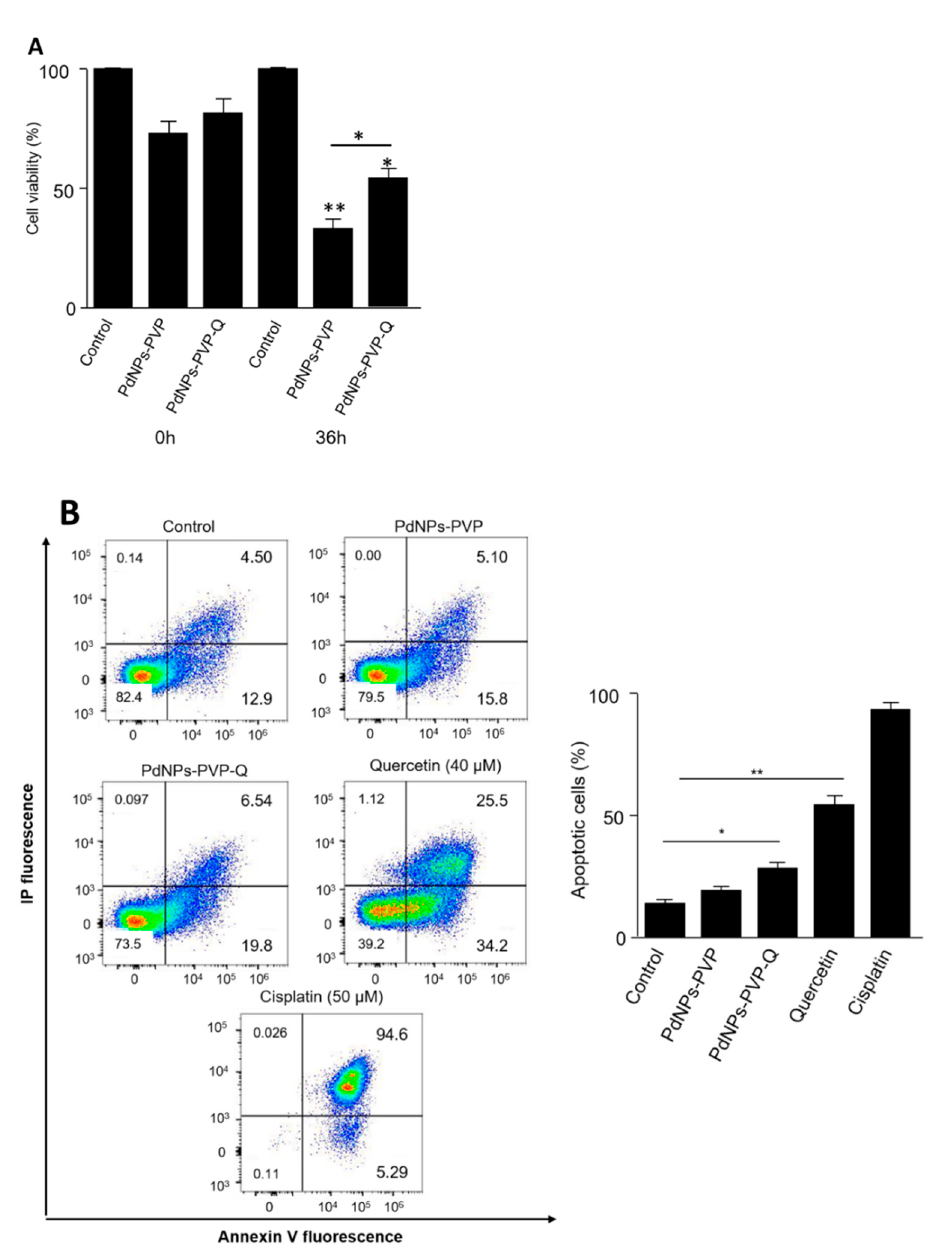
Figure 8. PdNPs-PVP-Q effects in HCT-15 cancer cells. ( A ). Cell proliferation assays were evaluated by MTT experiments. ( B ). Effect of PdNPs-PVP-Q on cell death. Graphs show the distribution of cell populations stained with Annexin-V and iodide propidium (IP) and sorted by flow cytometry. All assays were done in triplicate. Significance differences were indicated by * p < 0.05 and ** p < 0.005.